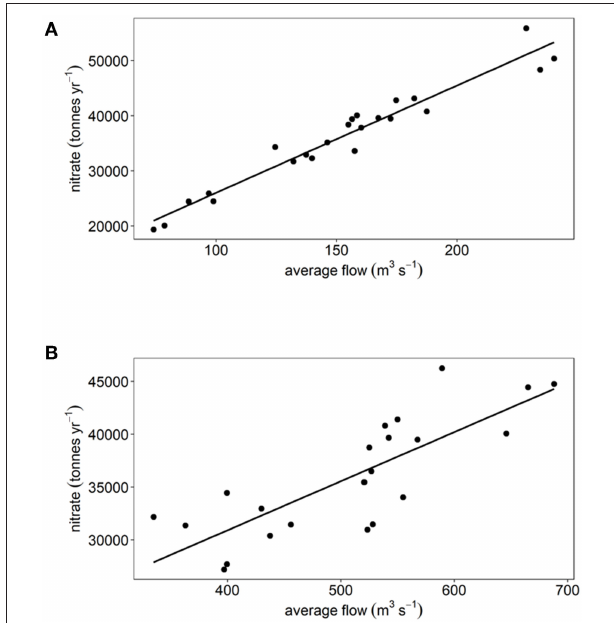
FIGURE 4 | Annual nitrate load plotted against average flow rate for (A) Thames and (B) Liverpool